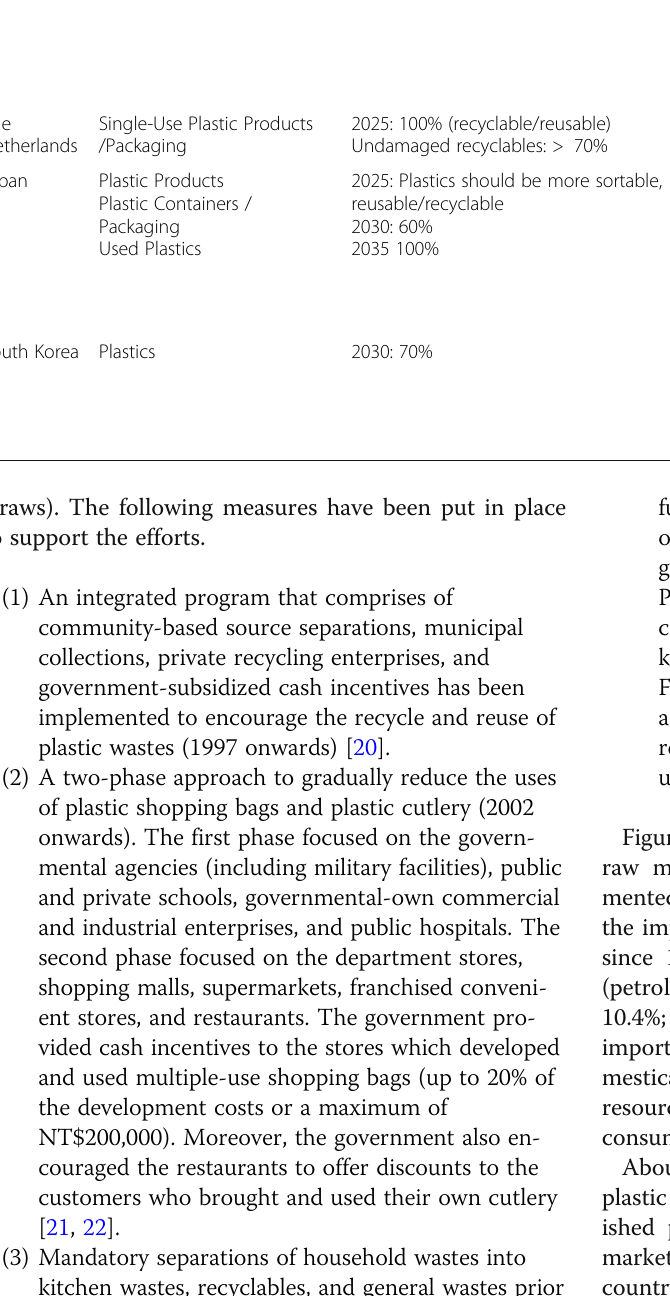
The Netherlands